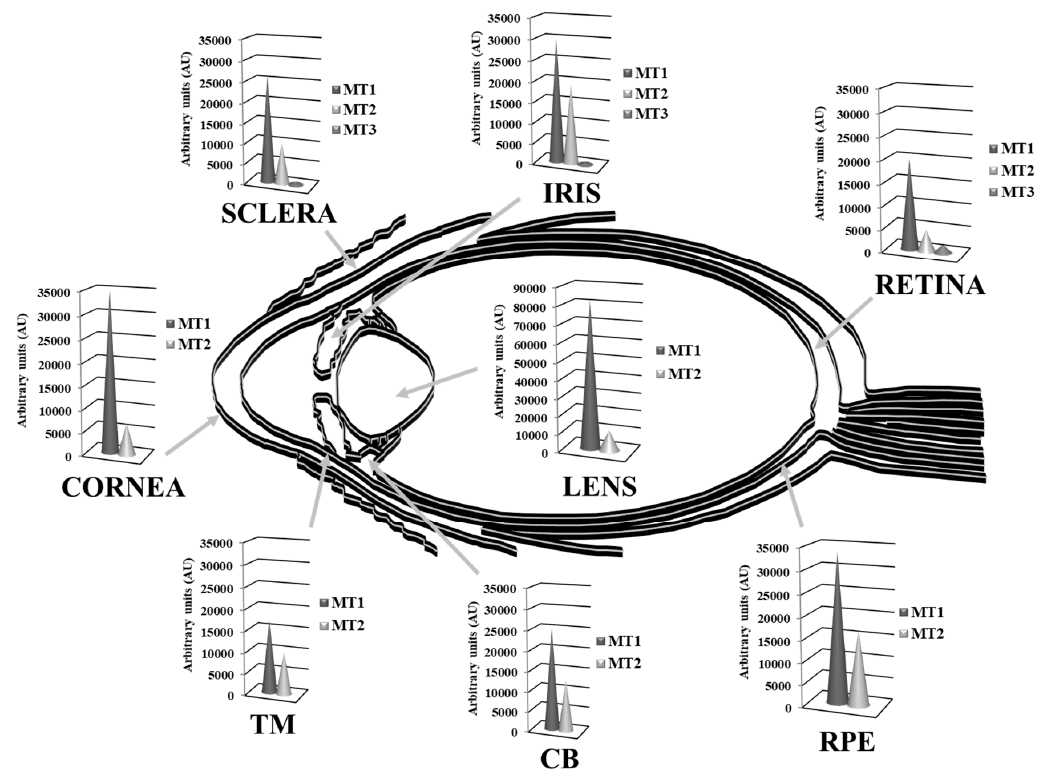
Figure 4. Gene expression profiling of MT1 (MT1A, MT1B, MT1E, MT1F, MT1G, MT1H, MT1M AND MT1X), MT2 (MT2A) and MT3 isoforms in human eye tissues, according to Alvarez et al., 2012 [15] and adapted, expressed in arbitrary units (AU) after normalization with internal controls. Scale bars of Y-axis range from 0 to 35,000 AU for each eye tissue, with the exception of lens, which Y-axis scale bar ranges from 0 to 90,000 AU. Using micro-dissected human lens epithelial cells and fibers, Oppermann et al. 2001 [235] analyzed the MT expression at mRNA level by reverse transcription polymerase chain reaction (RT-PCR) and at a protein level by immunoblotting, observing different spatial expression patterns. Specifically, MT1E, MT1F, MT1G, and MT1H isoforms were detected in both lens epithelium and fiber cells, while MT1E and MT1F isoforms were expressed at slightly higher levels in the epithelium than in the lens fibers. By contrast, MT2A was only detected in lens epithelium, although low amounts of MT2A were de- tected in fibers from individual lenses presenting very high amounts of RNA. Due to the low amplification specificity, spatial analysis was not performed on isoform MT1L. At protein level, a predominance of MT protein in the lens epithelium relative to the fibers was observed. These reported differences in the spatial expression patterns between MT1 and MT2 may indicate distinct roles for these isoforms in the human lens. According to Tate et al. 2002 [236], within the RPE and choroids, the MT isoforms were detected by in situ hybridization, and to a lesser extent, in the sclera. The RT-PCR analysis corroborated the in situ hybridization findings and demonstrated that MTs were mainly distributed in the RPE and the photoreceptor layer of the retina. Moreover, the high metabolic oxygen flux and high phagocytic activity of the RPE correlate with the high expression levels of MT isoforms and their protective function against apoptosis and oxidative stress [ Error! Bookmark not defined. , Error! Bookmark not defined. ]. Interestingly, MT3 isoform is preferentially distributed in the cytoplasm of the RGCs and the retinal nerve fiber layer (NFL), while is also localized in the stromal cells cyto- plasm of the iris [ Error! Bookmark not defined. ]. The cell-restricted and isoform-specific MT3 detection in RGCs may reflect biochemical and/or physiological differences with